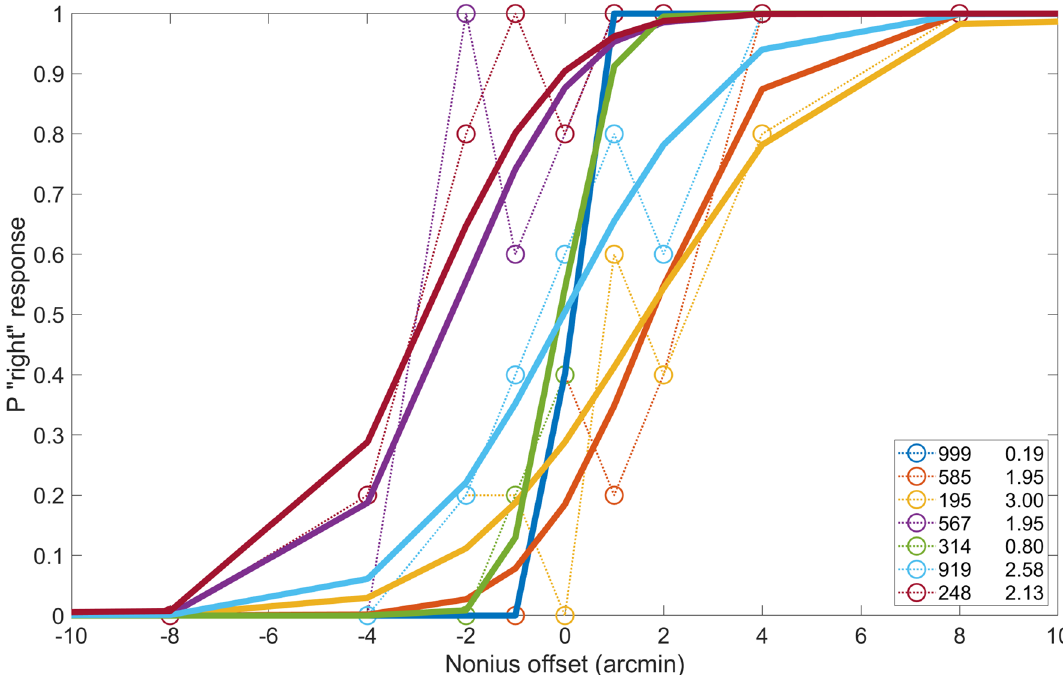
Figure 1. Nonius offset discrimination curves for seven subjects. Positive values of offset on the horizontal axis indicate that the right nonius line was shifted up relative to the left line, negative values indicate that the left line was shifted up. The vertical axis shows the probability that subjects indicated that the right line appeared higher. The precision of the nonius alignment judgments is indicated by the standard deviation of the best fitting cumulative normal curve, and these values are shown in the legend for each subject. Raw data (circles and thin lines) are shown along with fitted cumulative Gaussian functions (solid lines). Subjects could reliably detect offsets of 3 arc minutes or less. Subjects 999 and 585 are the